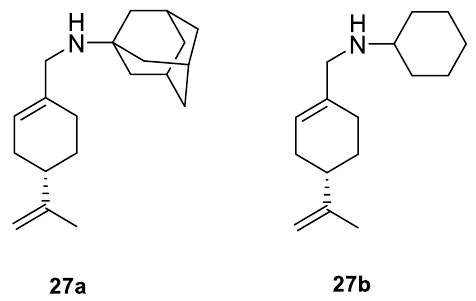
Figure 14. Chemical structure of most potent PAH derivatives.